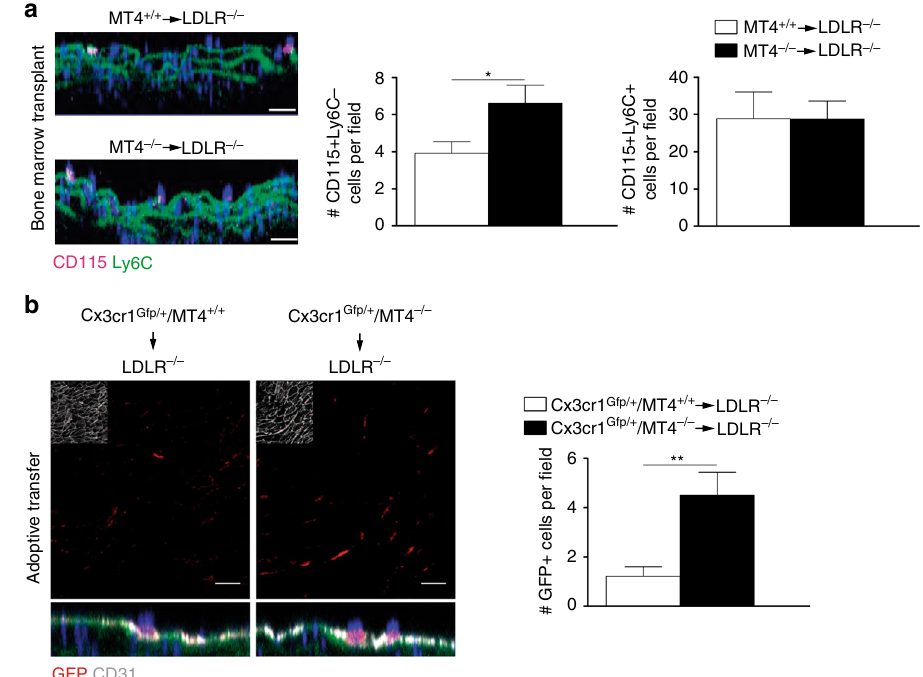
Fig. 5 Increased recruitment of MT4-MMP-null patrolling monocytes in incipient atherosclerotic lesions. a Representative orthogonal XZ view images of whole-mount-stained lesser curvature of the aortic arch from Ldlr – / – mice transplanted with MT4-MMP + / + or MT4-MMP – / – BM cells and fed a HFD for 3 days. Samples were stained for CD115 (magenta) and Ly6C (green); elastin auto fl uorescence (green) and nuclei (Hoechst, blue). The bar graph (right) shows the quanti fi cation of the number of patrolling (CD115 + Ly6C – ) and classical monocytes (CD115 + Ly6C + ) in the aorta lumen; n = 6 mice per genotype in two independent experiments. b Representative confocal microscopy images of whole-mount-stained lesser curvature of the aortic arch from Ldlr – / – mice adoptively transfer with Cx3cr1 Gfp/ + MT4-MMP + / + or Cx3cr1 Gfp/ + MT4-MMP – / – patrolling monocytes and fed a HFD for 3 days. Samples were stained for GFP (red) and CD31 (gray); elastin auto fl uorescence (green) and nuclei (Hoechst, blue). A z-stack of the confocal microscopy sections close to the lumen (with an inset of CD31 staining) is shown to the top and the orthogonal XZ view of the merged images to the bottom. Scale bar, 20 µ m. The bar graph (right) shows the quanti fi cation of the number of transferred monocytes (GFP + ) in the aorta lumen; n = 9 mice per genotype in two independent experiments. Data were tested by Student ’ s t -test. Results are expressed as mean ± SEM.* p < 0.05, ** p <